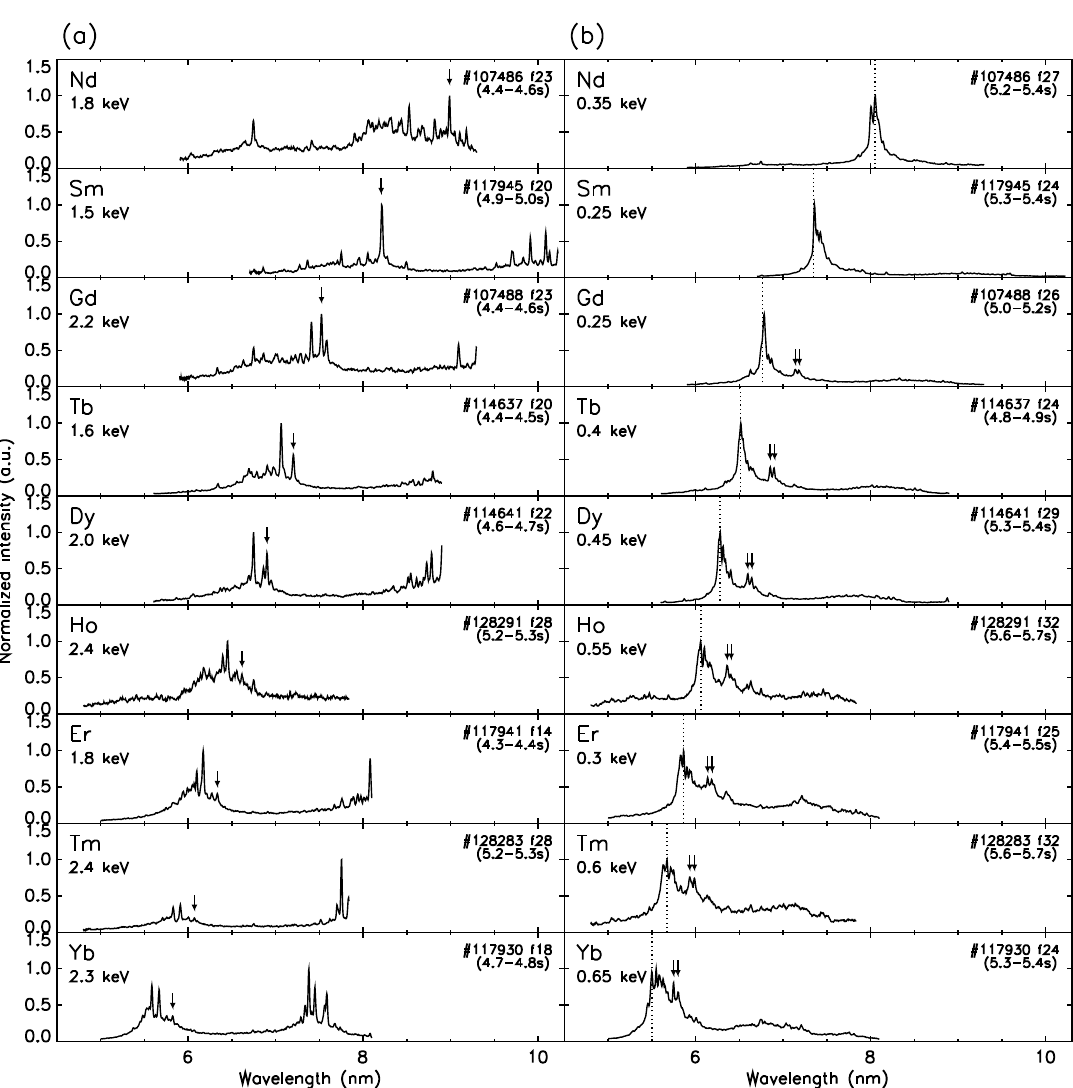
Figure 1. EUV spectra from nine lanthanide ions with Z from 60 (Nd)–70 (Yb) observed in LHD plasmas under ( a ) high temperature and ( b ) low temperature time frames in the same discharge. The peak electron temperatures corresponding to each spectrum are shown in each panel. All the spectra drawn here are normalized to each maximum. Hollow plasmas are formed in (b), except for Yb. The arrows in (a) indicate the positions of 3d 10 4p 2 P 1/2 – 3d 10 4d 2 D 3/2 transitions of Cu-like ions, while those in (b) indicate the 4d 10 4f 2 F–4d 9 4f 2 2 G doublet of Ag-like ions. Dotted lines in (b) denote the positions of the 4d 10 1 S 0 –4d 9 4f 1 P 1 transitions of Pd-like